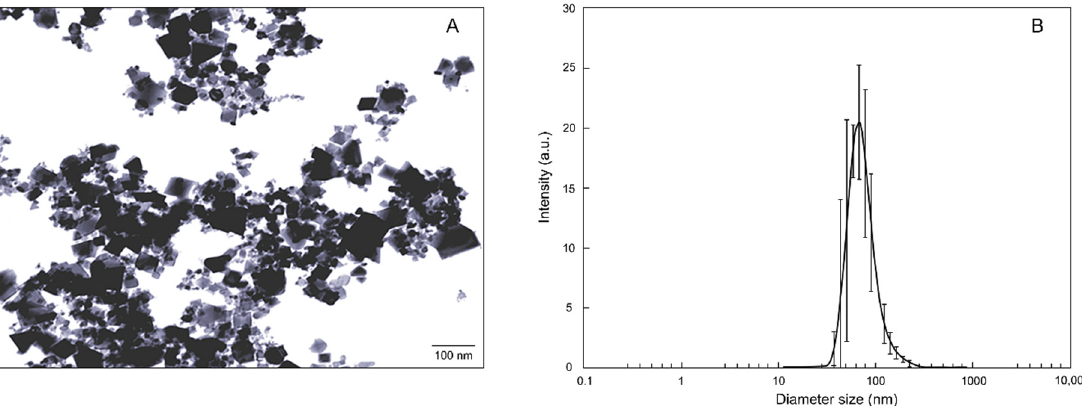
Figure 2. ( A ) Particle size distribution obtained by dynamic light scattering (DLS). ( B ) Transmission electron microscopy (TEM) image of n CeO 2 25 nm suspension.